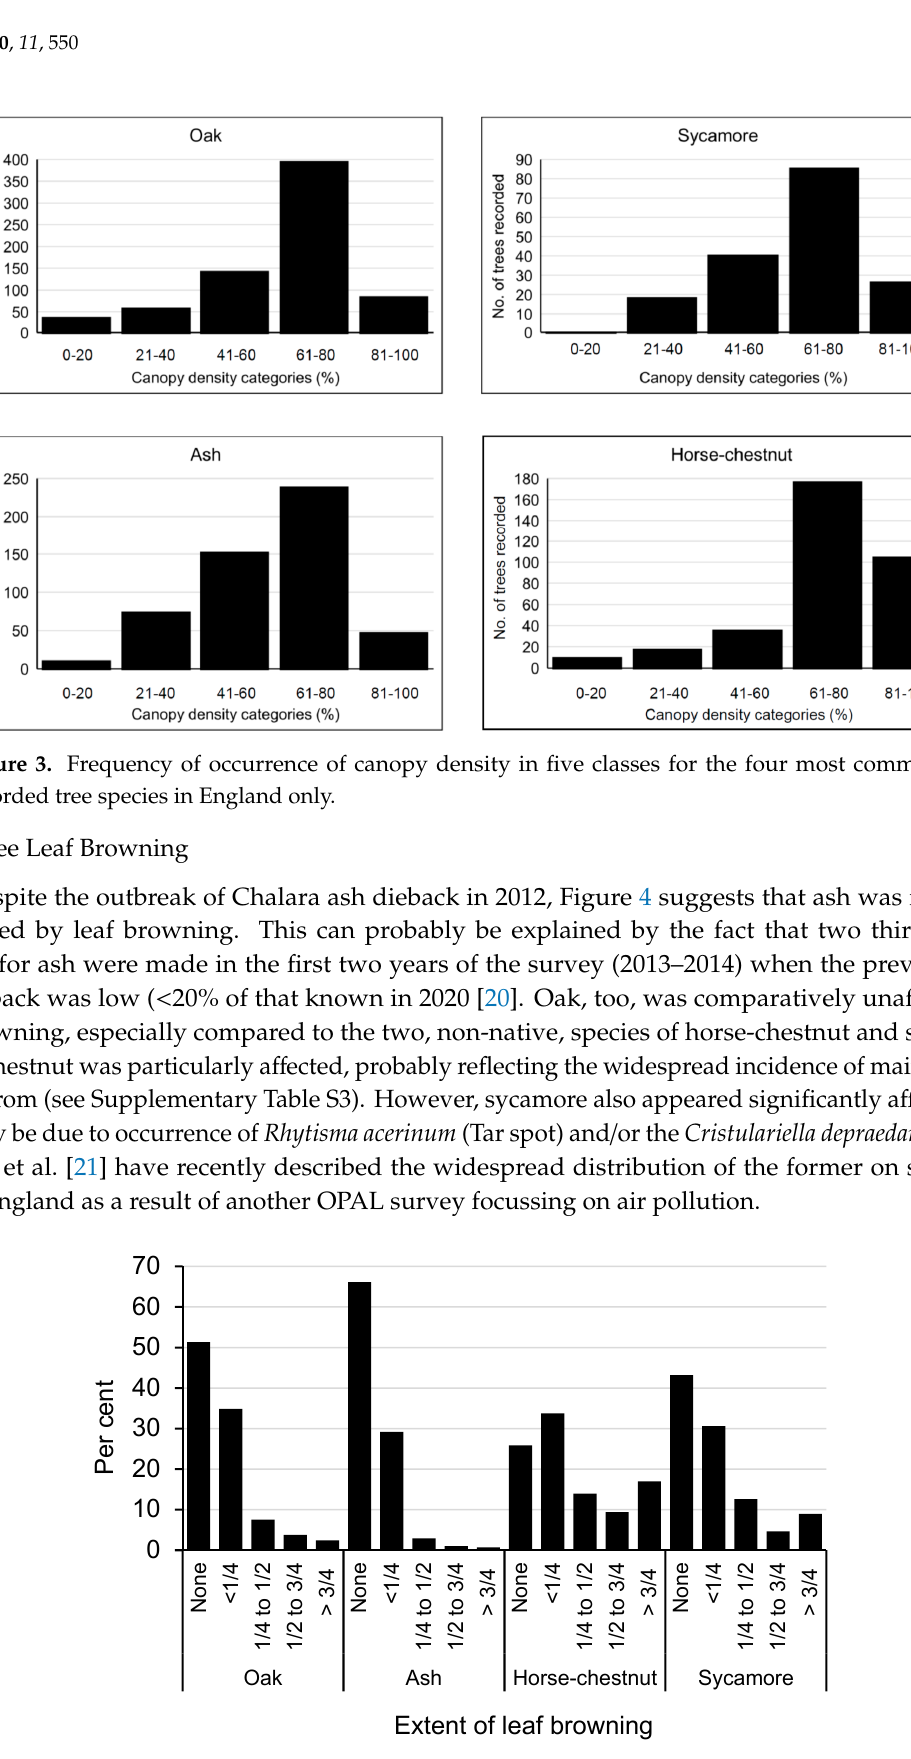
Figure 4. Frequency of occurrence of leaf browning for the four most commonly recorded tree species in England only.